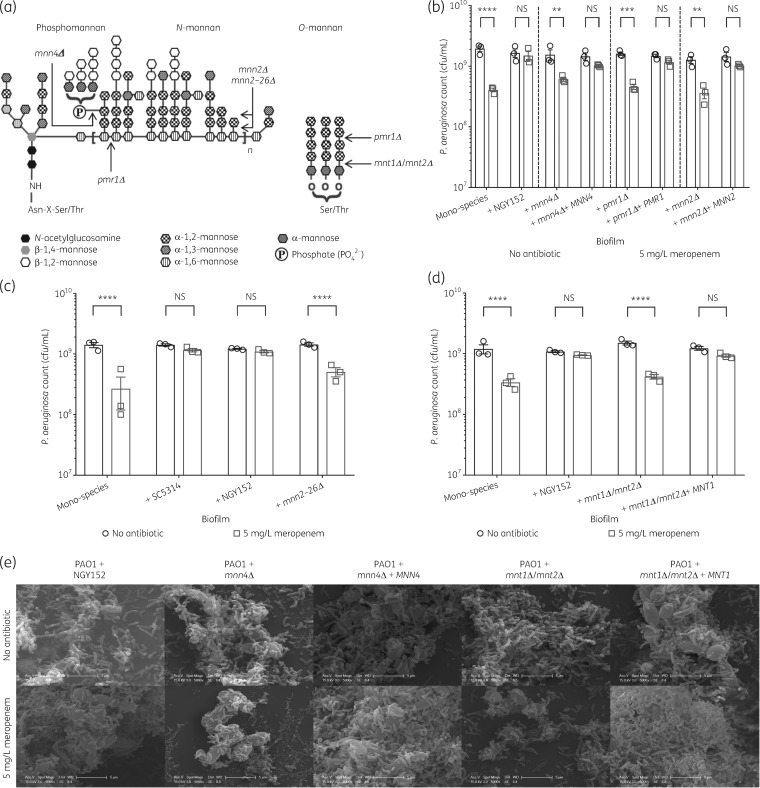

C. albicans cell wall glycosylation is important for protection against meropenem. (a) Schematic diagram representing the structure of N-mannan (including phosphomannan) and O-mannan of C. albicans.44,46 The points of truncation of the mutants used in this study are indicated by arrows. The pmr1Δ mutant causes loss of a Golgi Ca2+/Mn2+-ATPase, affecting numerous mannosyltransferases, so the extent of truncation of the α-1,6-mannose backbone is variable.44,45 (b) N-mannan glycosylation is important for protection against meropenem. Preformed 24 h biofilms were incubated for 18 h in MHB containing no antibiotic or 5 mg/L meropenem. The N-mannan glycosylation mutants (mnn4Δ, pmr1Δ or mnn2Δ) inhibit the ability of C. albicans to protect P. aeruginosa. Tolerance to meropenem is restored in reconstituted control strains. (c) The mnn2–26Δ sextuple mutant, in which only the unsubstituted α-1,6-mannose backbone of N-mannan remains, inhibits the ability of C. albicans to protect P. aeruginosa. (d) O-mannan glycosylation is important for protection against meropenem. The mnt1Δ/mnt2Δ double mutant inhibits the ability of C. albicans to protect P. aeruginosa. Meropenem tolerance is restored when MNT1 is reconstituted. Data are the mean ± SEM from three biological replicates. Data were analysed using two-way ANOVA and Holm–Sidak’s multiple comparisons test (**P < 0.01, ***P < 0.001 and ****P < 0.0001 in panels b, c and d). NS, not significant. (e) Scanning electron microscopy analysis of biofilms. Deletion of genes required for fungal N-mannan biosynthesis (mnn4) or O-mannan biosynthesis (mnt1/mnt2) reduced the ability of C. albicans to protect P. aeruginosa from meropenem, as indicated by the reduction in the number of bacterial cells following meropenem treatment; the majority of surviving bacteria are in close contact with fungal cells. When the genes (MNN4 or MNT1) are reconstituted, the protective effect is restored, as evidenced by the abundance of P. aeruginosa cells coating the fungi in the meropenem-treated samples.